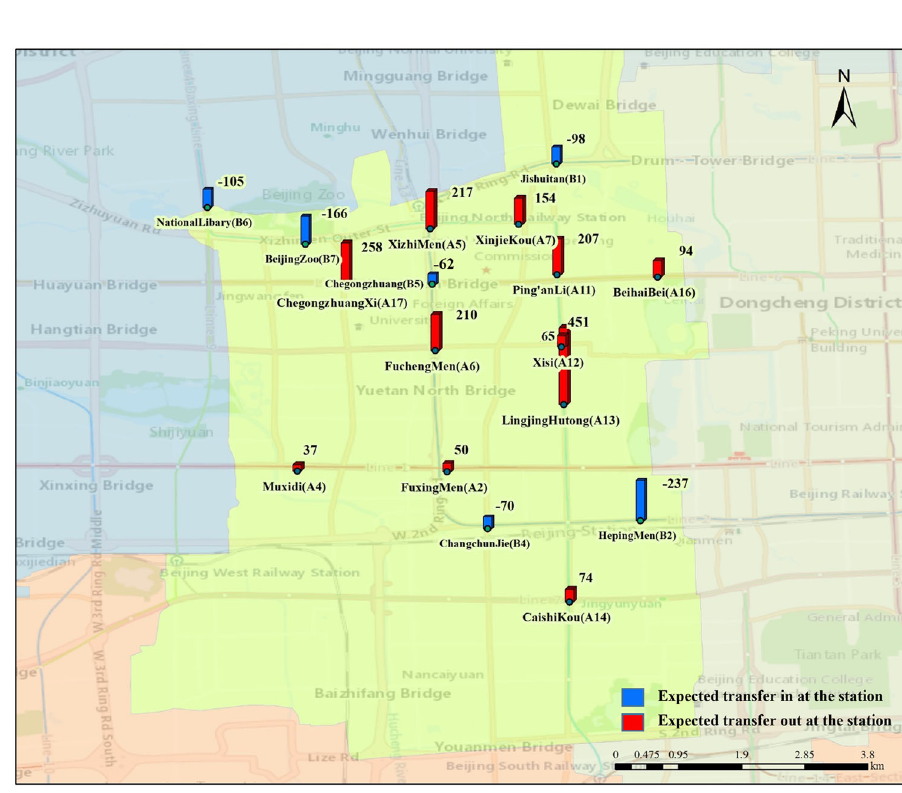
Fig. 6 Participating deployment sites of urban rail transit stations and deployment